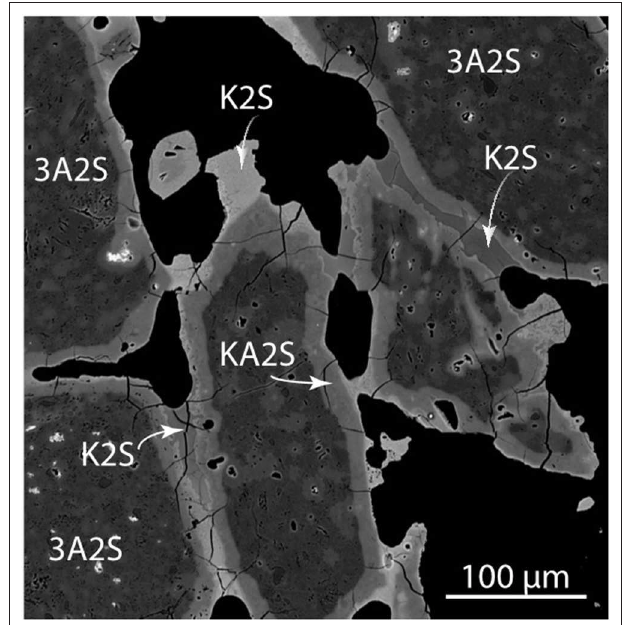
FIGURE 7 | Back-scattered electron image (mean-atomic density map) of corroded and agglomerated mullite bed particles (air gasification at < 750 o C). Scale bar is 100 microns. Image intensity is principally controlled by the concentration of potassium and aluminum. 3A2S, mullite; KA2S, kalsilite; and K2S, potassium disilicate; where A, S, K stand for the respective oxides Al 2 O 3 , SiO 2 , K 2 O. Variable shade of K2S reflects variable minor Al and Ca